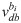
The impact of red blood cells balances outflow velocities at divergent capillary bifurcations and increases hematocrit heterogeneity in the capillary bed.(A-B) Absolute velocity difference at well-balanced and unbalanced divergent bifurcations for the simulation with red blood cells (RBCs) and with passive particles (pPs). vdbbi: bulk flow velocity in each daughter vessel of the bifurcation. vdb¯: mean velocity in the daughter vessels. n: total number of bifurcations. The bifurcations are grouped into well-balanced and unbalanced based on the results from the simulation with RBCs. The same sets of bifurcations are compared for both simulations. We only depict velocities up to 14 mm/s (represents > 99.9% of all bifurcations). (C) Microvascular network 1 (MVN 1). The colouring highlights capillaries and outflow vessels of capillary divergent bifurcations. (D) Hematocrit distribution for the simulation with RBCs and with pPs (n = 13,988, Q1: lower quartile, Q3: upper quartile, Definition boxplot: Methods). (E-F) Hematocrit distribution in MVN 1 for the simulation with RBCs (E) and with pPs (F). In all plots only the daughter vessels of divergent bifurcation are considered (‘outflow vessels’, 53% of all capillaries, Methods, S8 Fig). In (A), (B) and (D) the data from MVN 1 and 2 is combined.